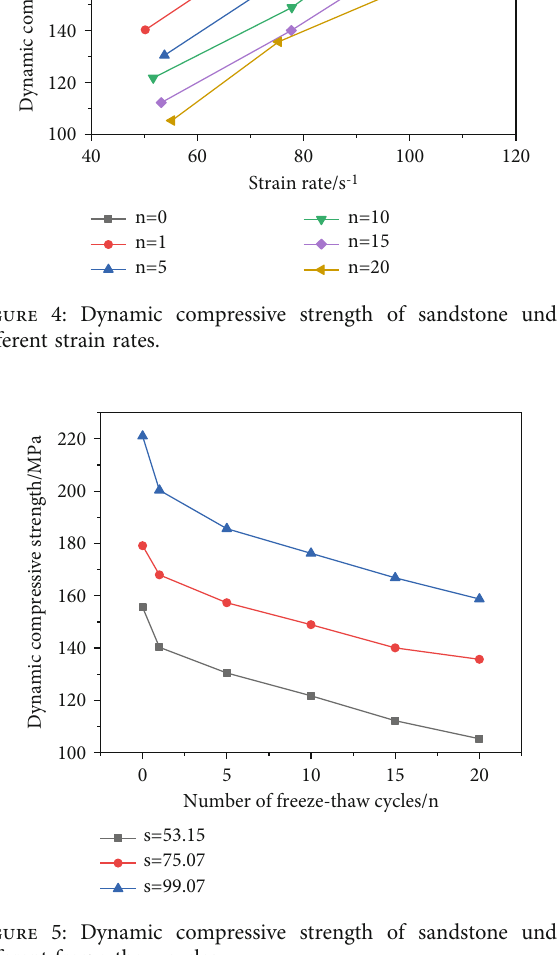
Figure 7: Dynamic axial strain of sandstone under di ff erent freeze- thaw